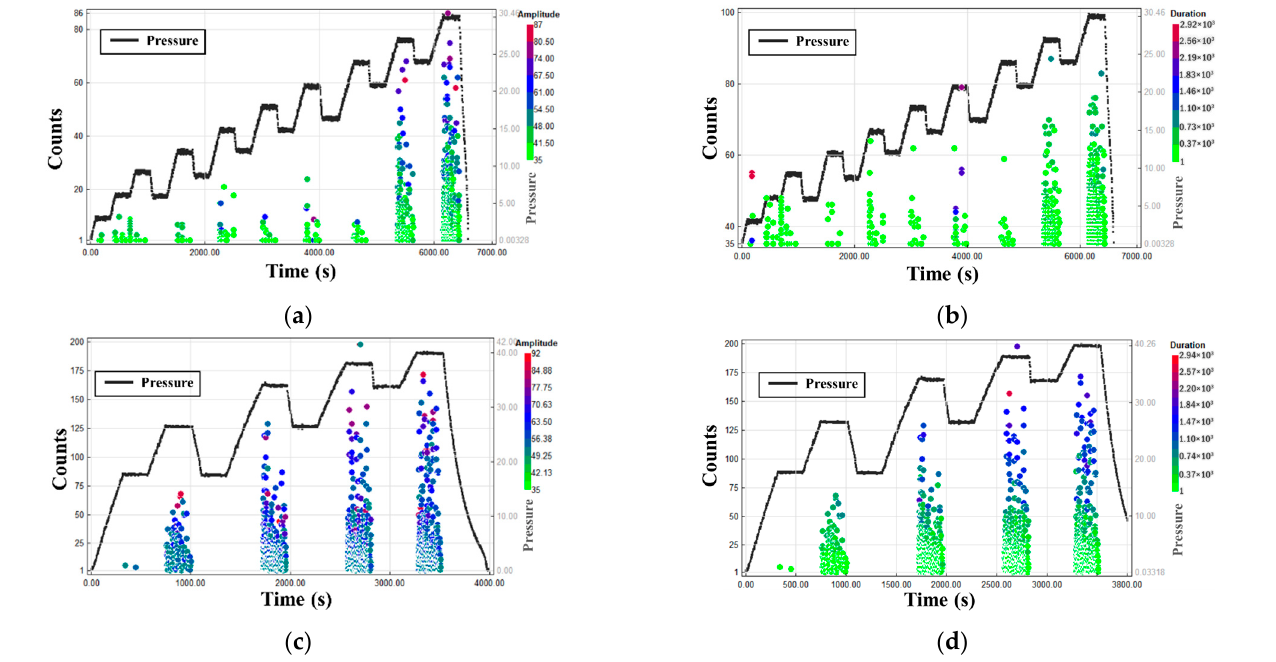
Figure 10. Time–counts–amplitude diagram: 0–30 ( a ) and 0–40 MPa ( c ); Time–counts–duration diagram: 0–30 ( b ) and 0–40 MPa ( d ).